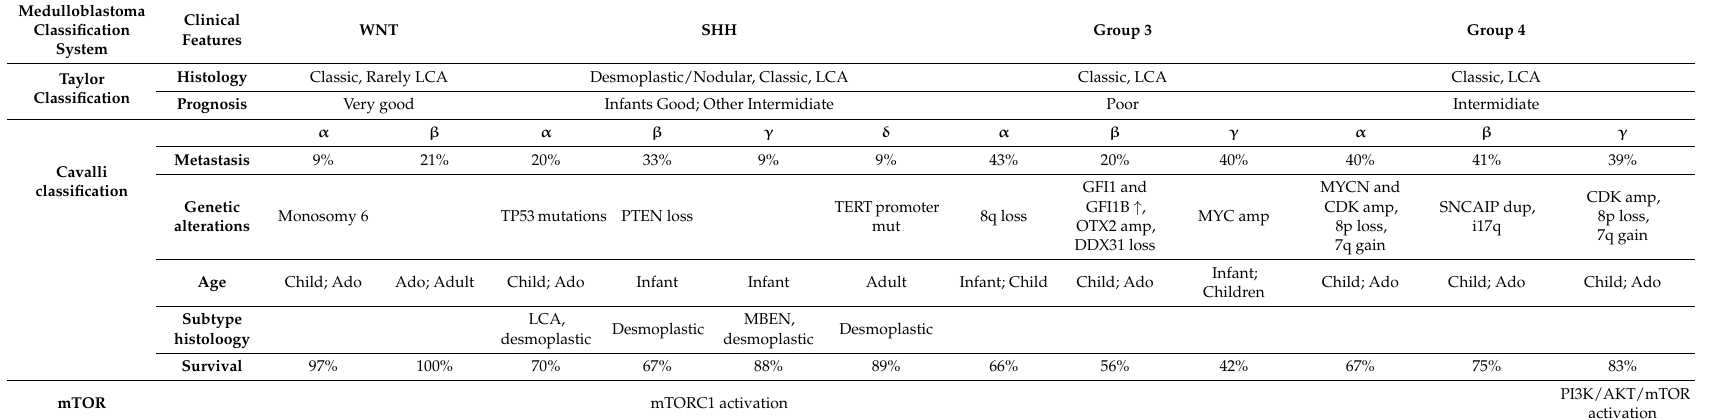
Table 1. Graphical summary of the different classification of medulloblastoma (MB) subgroups and their